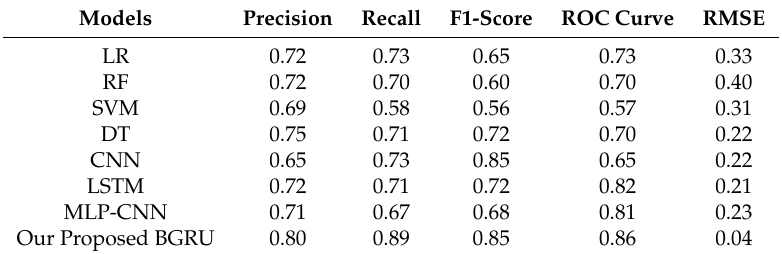
Table 4. Performance metrics.